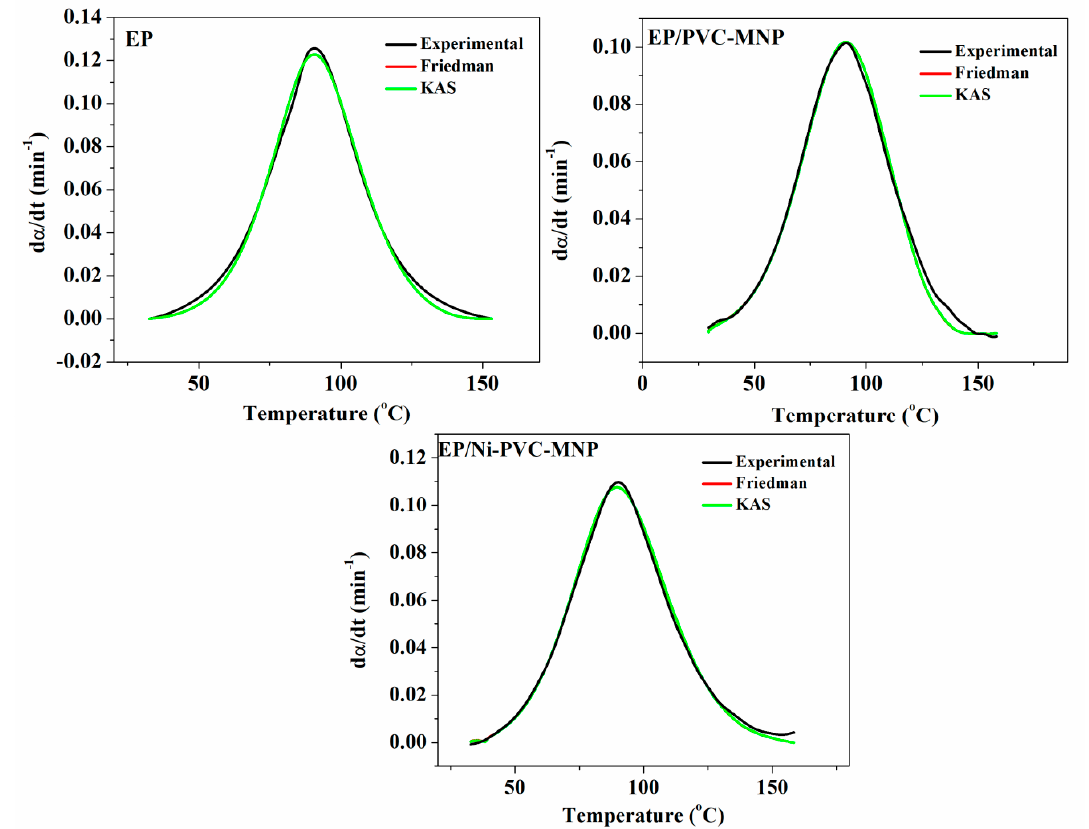
Figure 11. Typical of the experimental and the calculated rates of the cure reaction of the prepared samples at heating rate of 5 °C/min.